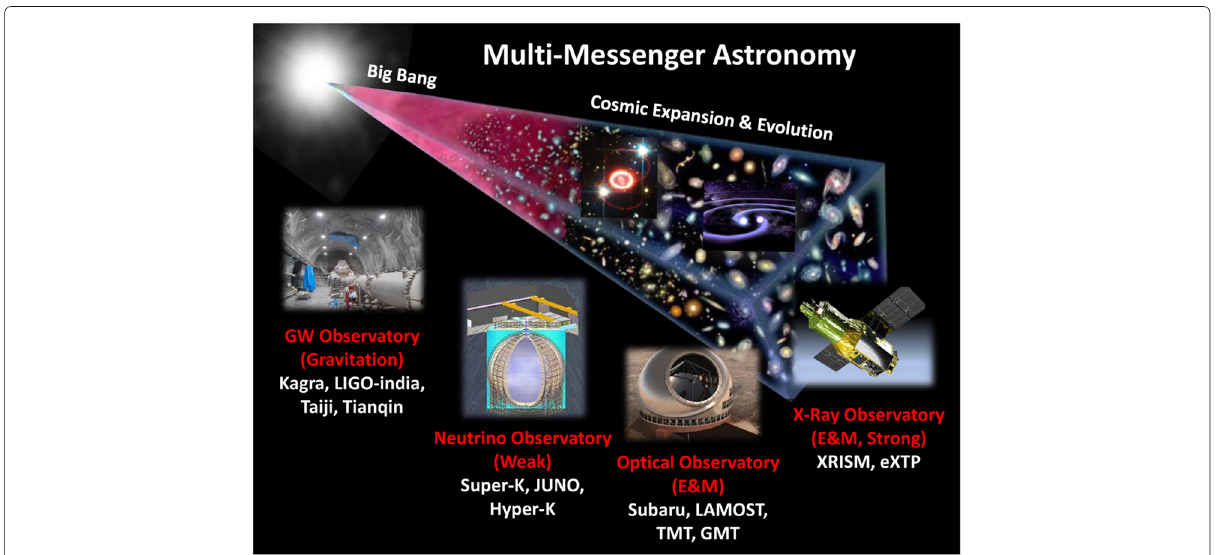
Fig. 8 Planned future observatories under the ground, on the ground and in the space to detect multi-messengers from the cosmos. GWs, neutrinos, optical-to-infrared photons, and X γ -rays are respectively the messengers of gravitational, weak, electromagnetic, and electromagnetic plus strong nuclear forces that make a variety of physical and chemical processes in the universe, galaxies, and stars